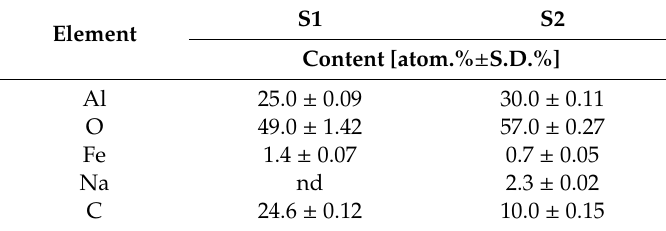
Table 3. Elemental content (EDS analysis) of